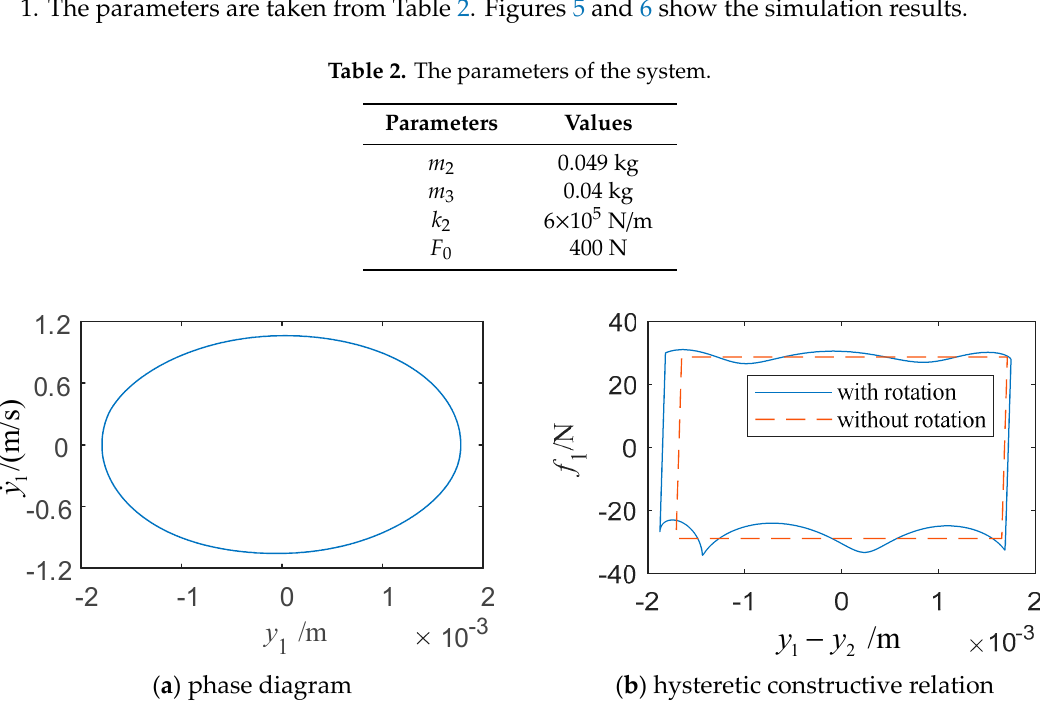
Figure 5. Phase diagram ( a ) and the hysteretic constructive relationship of f 1 and y 1 − y 2 ( b ) when the system reaches